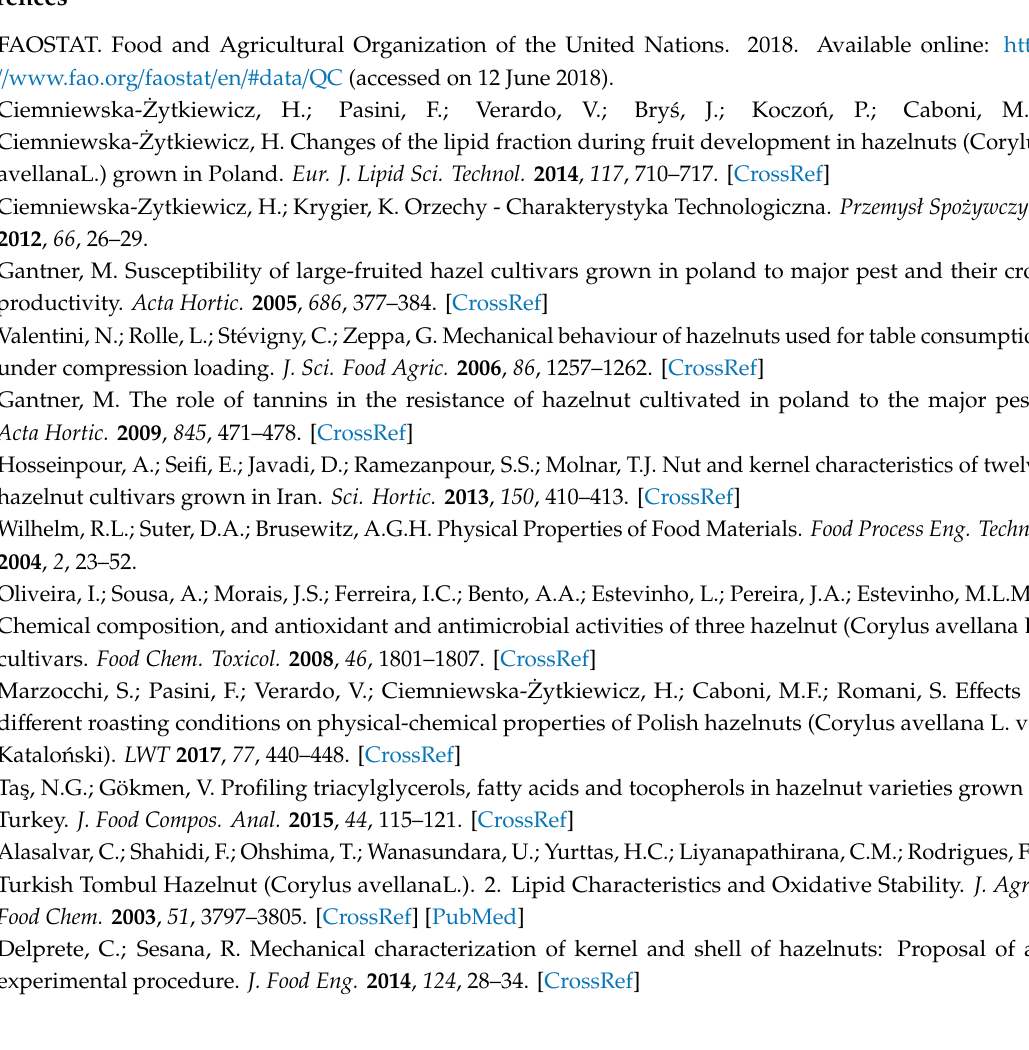
Figure S1: Weather conditions in orchard 2016–2017 in time of hazelnut kernels development, Table S1: Physical properties and geometric measurements of all six cultivars ( n =